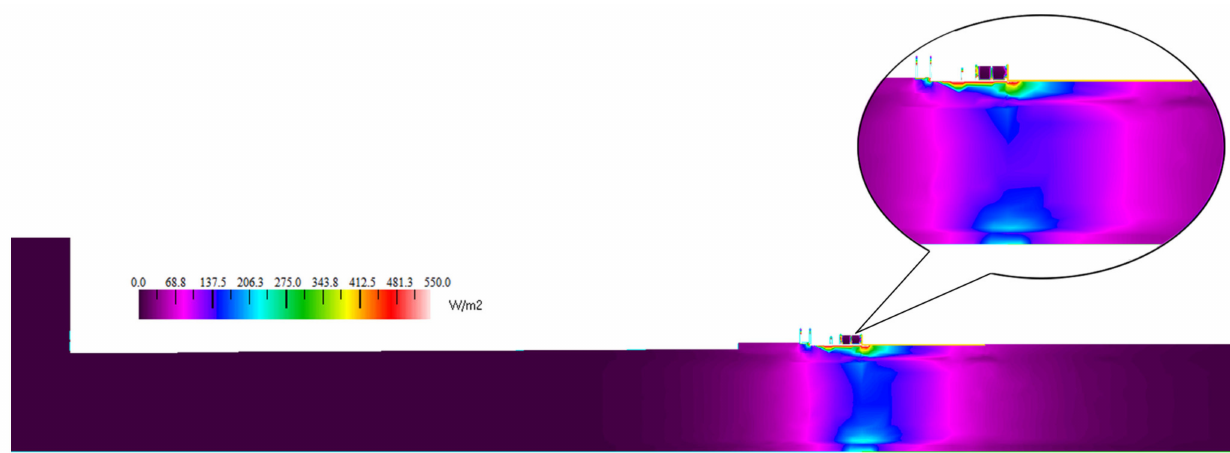
Figure 2. A 2D visualization of typical balcony section without thermal barrier.